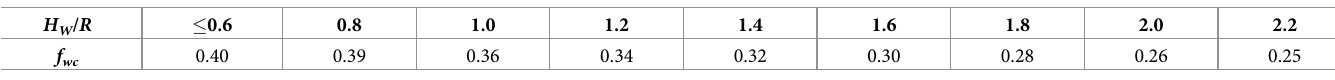
Table 2. Hydrodynamic pressure coefficient f